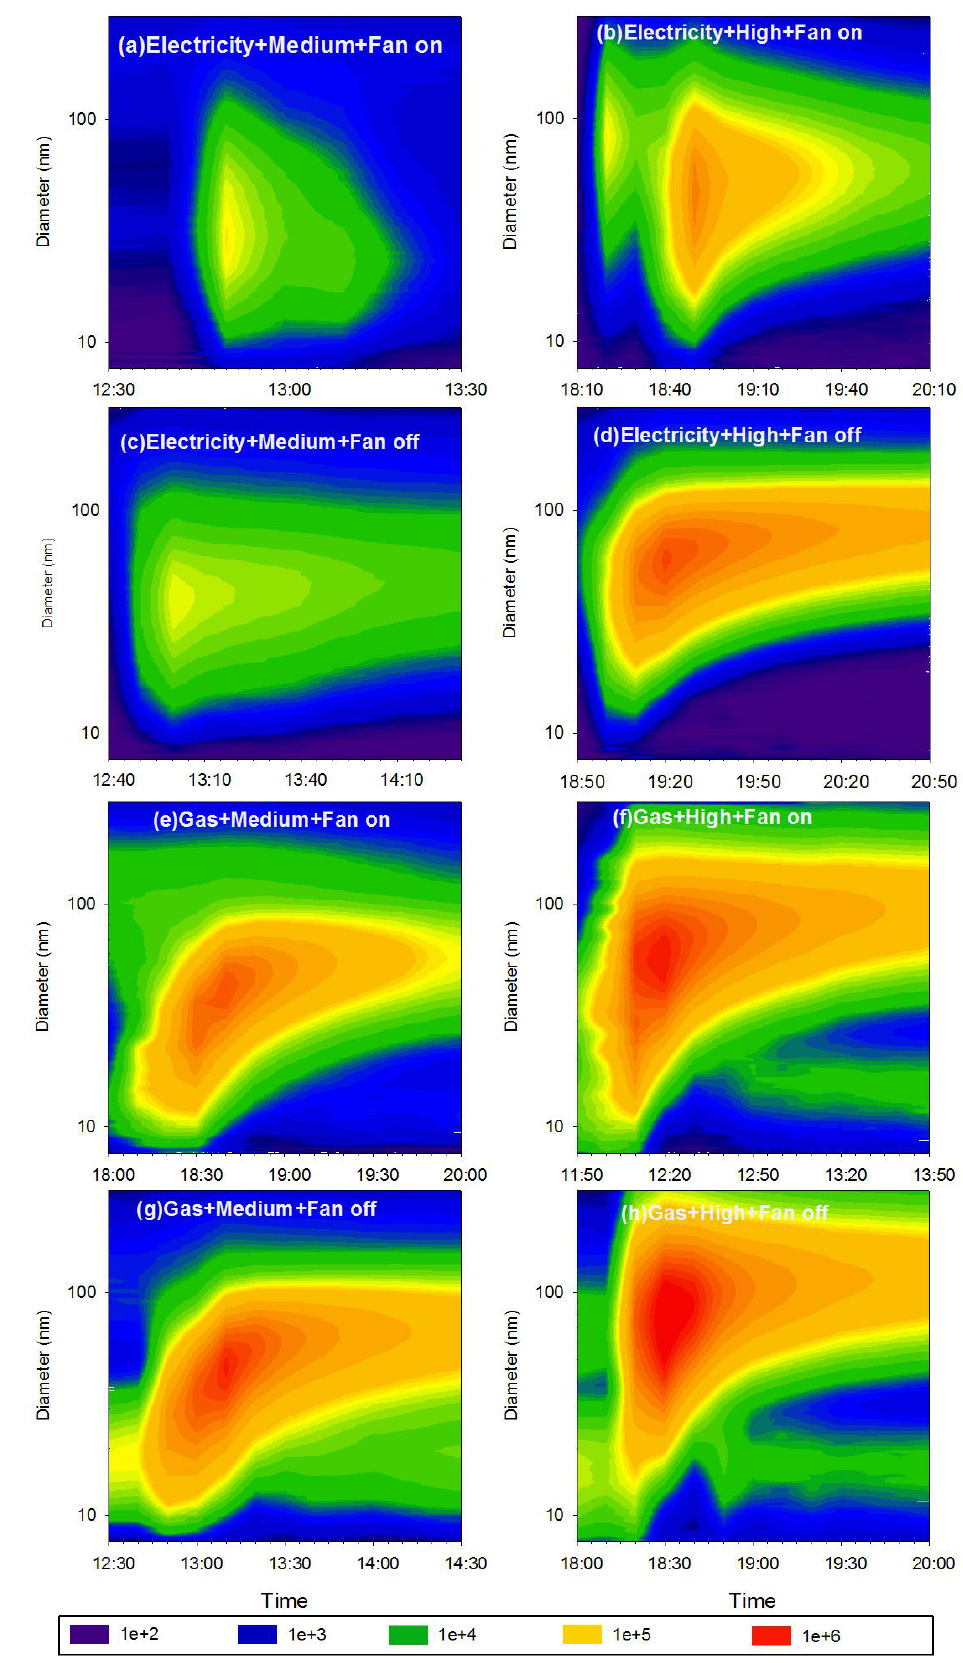
Figure 3. Number-based UFP size distributions as a function of time, shown for each set of cooking